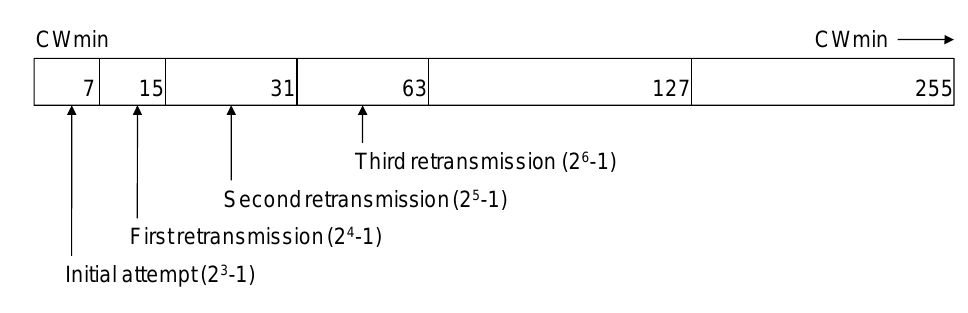
Figure 3. Contention window with defined threshold